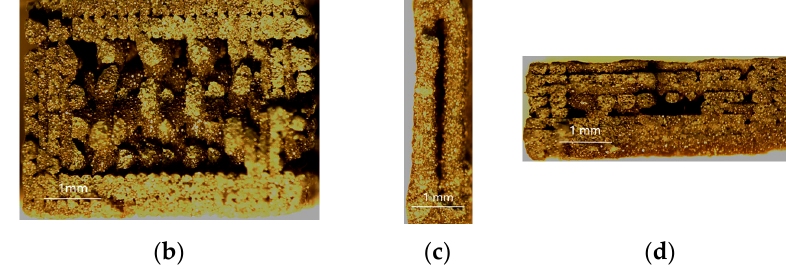
Figure 6. Cross-sections of the PLA + bronze specimens after fracture observed by means of a stereoscopic microscope, magnification ×12; ( a ) specimen 4.0 2Z, with visible black areas indicating lack of filament (1); ( b ) specimen 4.0 5Y; ( c ) specimen 1.0 2Z; ( d ) specimen 1.8 5X.